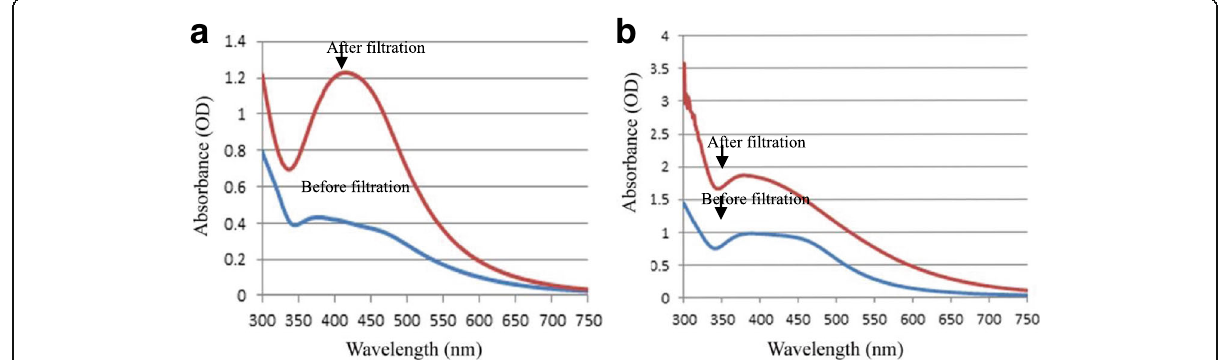
Fig. 4 UV – visible absorption spectrum of synthesized AgNPs by Trichoderma longibrachiatum for a 10 g biomass and b 15 g biomass, before and after filtration with filter size 0.22 μ m